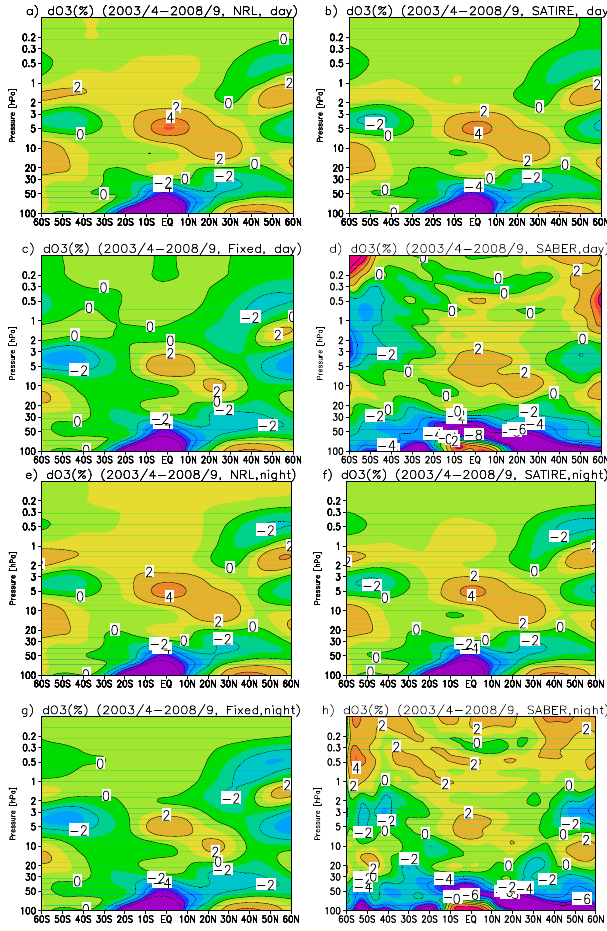
Fig. 6. Daytime (a–d) and night-time (e–h) biannual mean zonal mean O 3 differences (%) between 2003/2004 and 2008/2009 for ( a and e ) SLIMCAT run A_NRL , ( b and f ) SLIMCAT run B_SATIRE , ( c and g ) SLIMCAT run C_FIX and ( d and h ) SABER